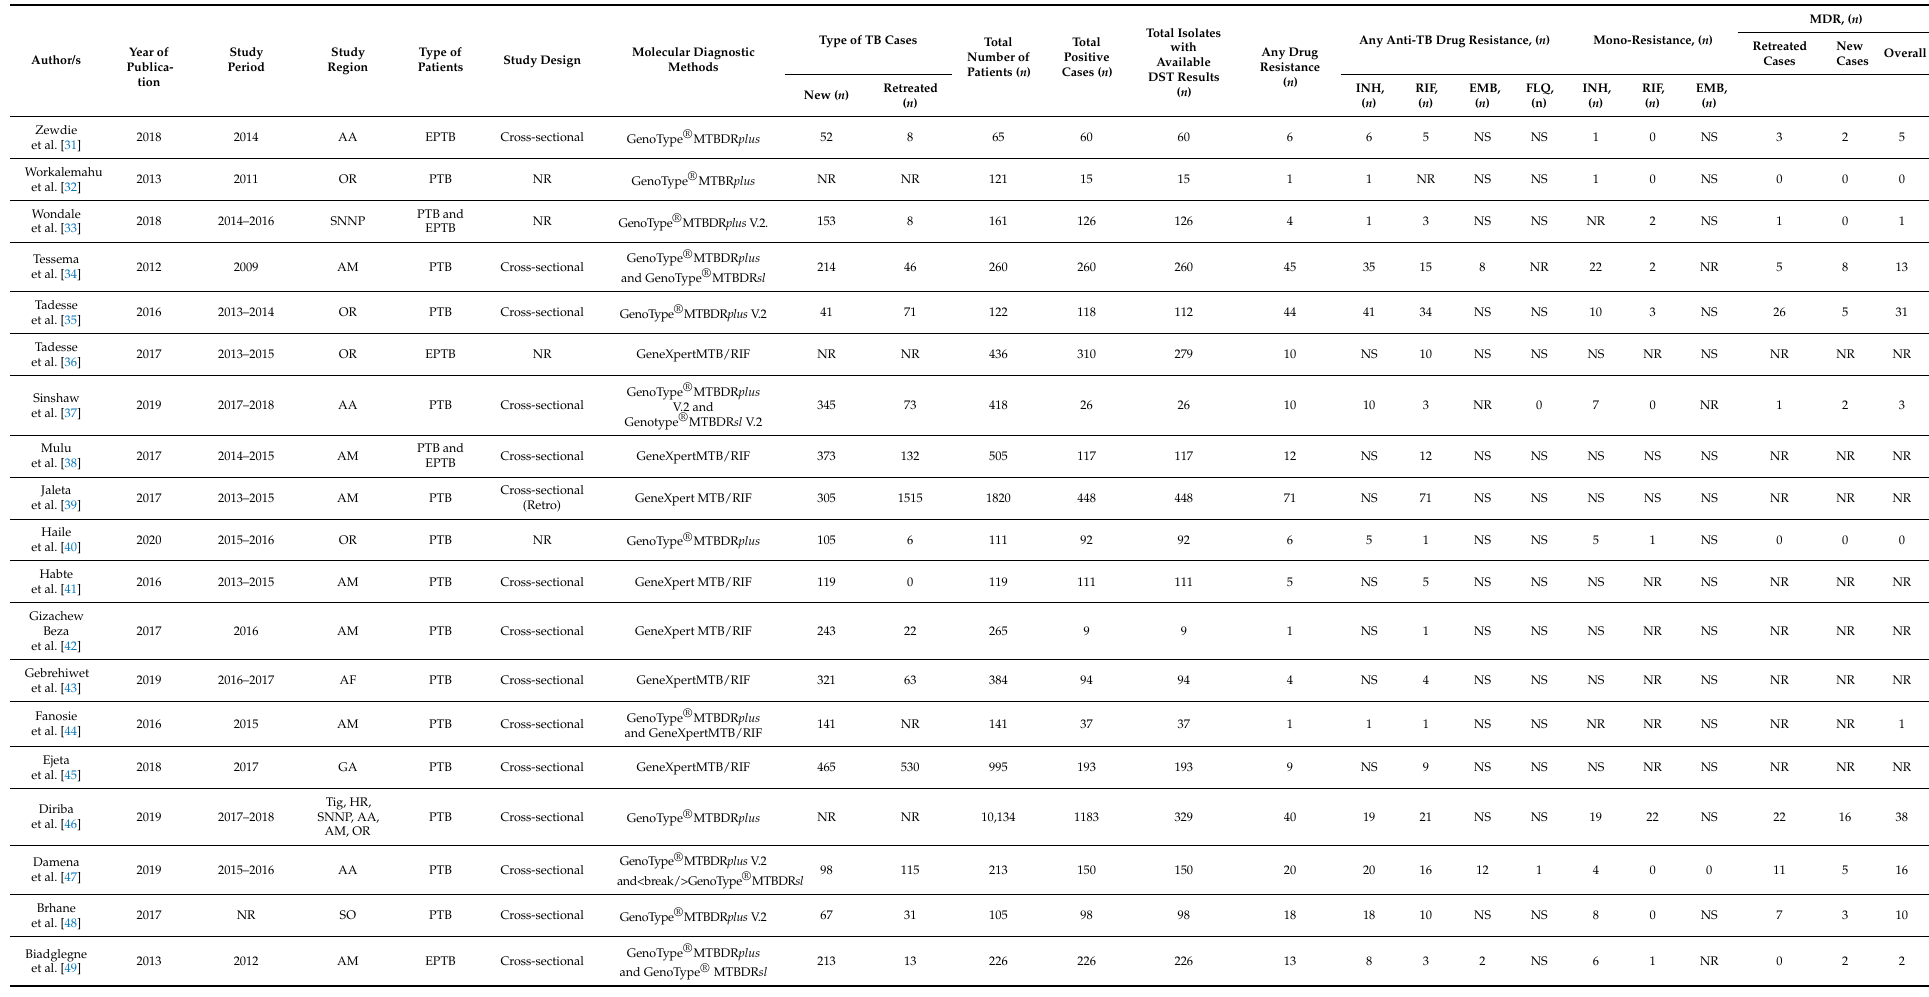
Table 1. Characteristics of included